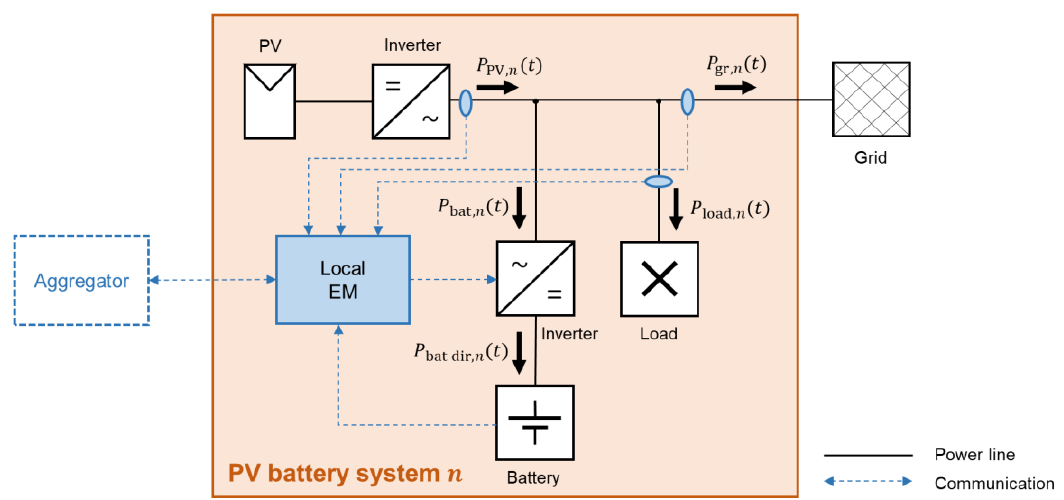
Figure 3. Topology of a single PV battery system.